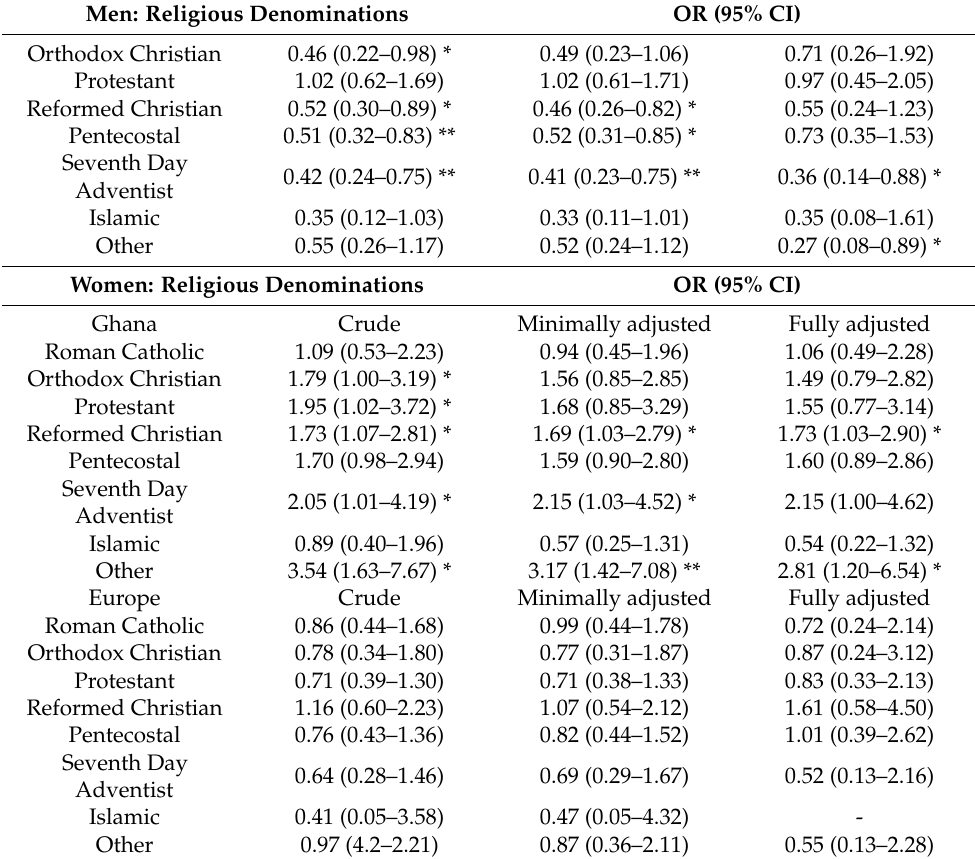
Table 4. Cont. Men: Religious Denominations